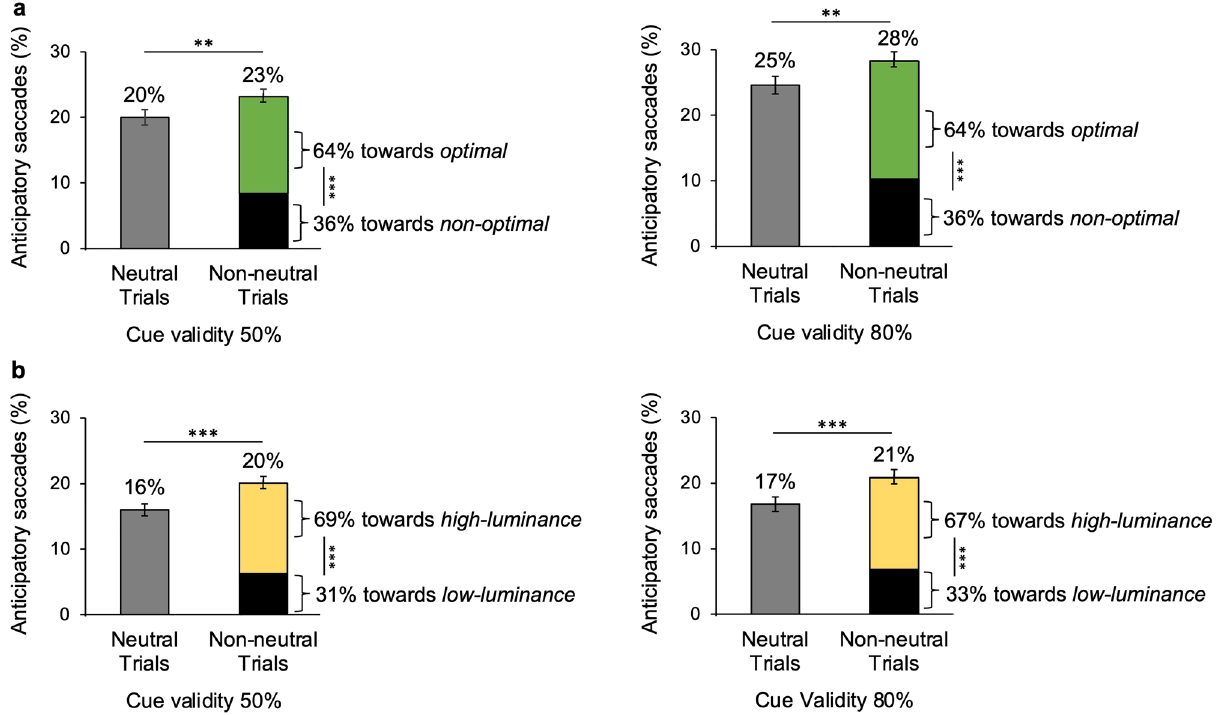
Figure 6. Percentage and direction of anticipatory saccades in neutral and non-neutral trials. Percentages shown above bars are computed over the total number of saccades. Percentages shown on the sides of green/ black and yellow/black bars are computed over the number of anticipatory saccades done in non-neutral trials and represent the preferential direction towards which these saccades are directed. Binomial data were considered as normally distributed due to the numerosity of observations for each trial type (> 30). (a) Experimental condition. The percentage of anticipatory saccades in non-neutral trials (green/black bars) is higher than that in neutral (grey bars), for 50% (left panel; z = 2.33, p = 0.009) and 80% cue validity (right panel; z = 2.70, p = 0.003). Anticipatory saccades in non-neutral trials are preferentially directed to the optimal feature (green) compared to the non-optimal one (black) (50% cue validity— z = 11.27, p < 0.001; 80% cue validity— z = 12.57, p < 0.001). (b) Control condition. The percentage of anticipatory saccades in non-neutral trials (yellow-black bars) is higher than that in neutral (grey bars), for 50% (left panel; z = 3.42, p < 0.001) and 80% cue validity (right panel; z = 3.30, p < 0.001). Anticipatory saccades in non-neutral trials are preferentially directed to the high-luminance feature (yellow) compared to the low-luminance one (black) (50% cue validity: z = 14.39, p < 0.001; 80% cue validity: z = 13.22, p < 0.001). Asterisks mark statistically significant pairwise comparisons across trial types: ** p < 0.01, *** p < 0.001. Error bars are